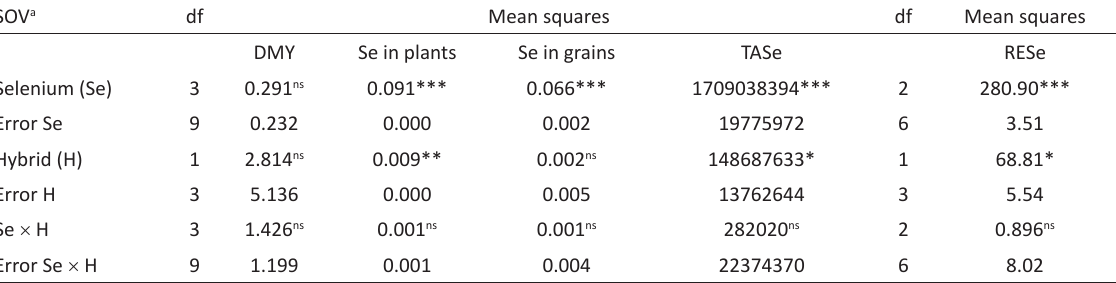
Table 3. Analysis variance (showing mean squares) for the effects of the experimental treatments on the selenium content and biomass yield of the maize in 2015 SOV a df Mean squares df Mean squares DMY Se in plants Se in grains TASe RESe Selenium